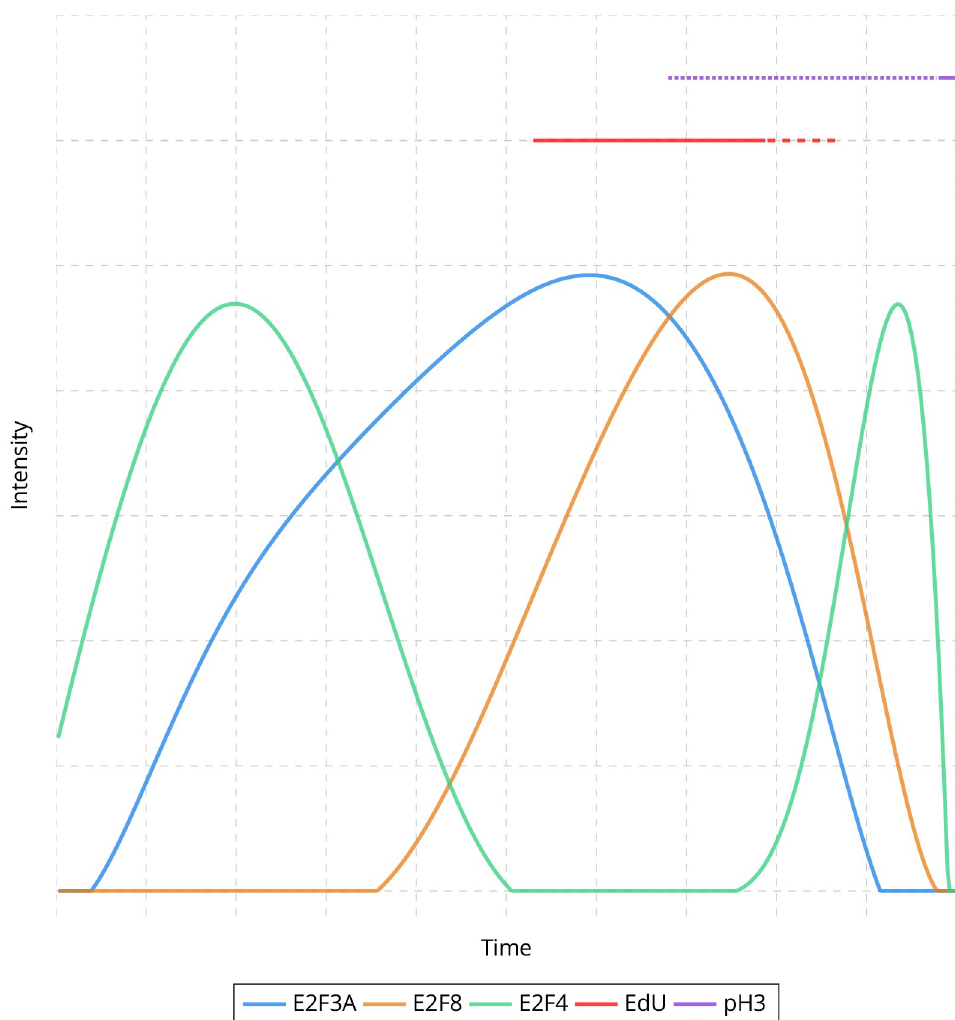
Fig 3. Estimation of E2Fs evolution over the cell cycle. Temporal evolution of E2F3A, E2F8 and E2F4 protein accumulation, as well as EdU and pH3 patterns over the cell cycle in mouse intestinal epithelium.